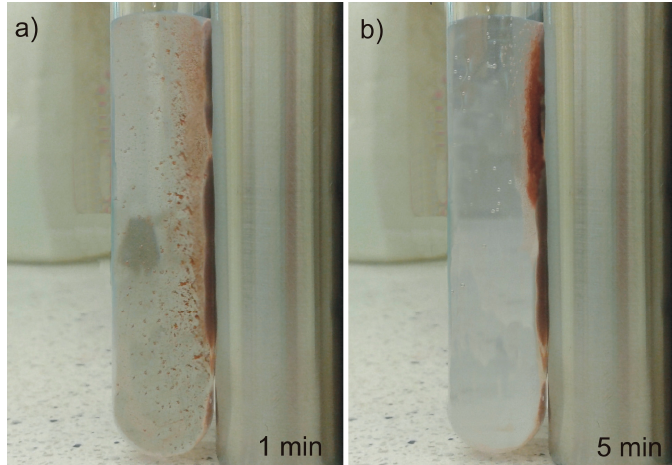
Figure 8. Image of CoFe 2 O 4 /SiO 2 /TiO 2 magnetic separation after 1 min ( a ) and 5 min ( b ) after applying magnet